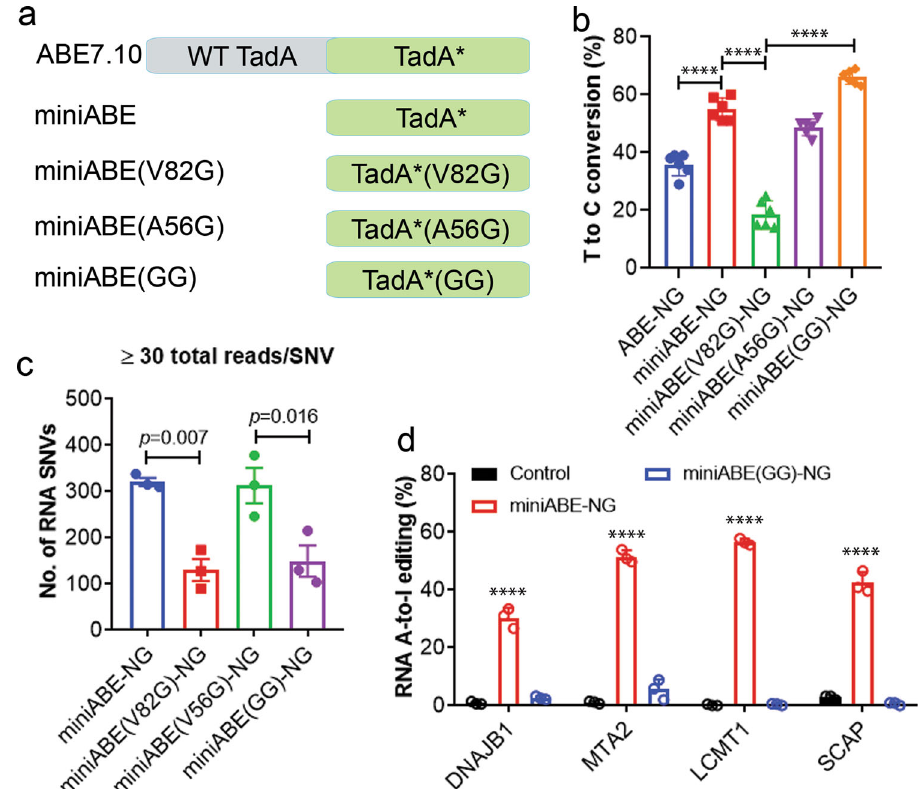
Fig. 3 Re-engineering the adenine deaminase domain to improve the ef fi ciency and speci fi city of ABE-NG. a Schematics of the adenine deaminase domain used in ABE-NG editors. b Quanti fi cation of the editing ef fi ciency of different ABE-NG variants with modi fi ed TadA* domain at the mdx 4cv target site. n = 6 wells/group; **** p < 0.0001; one-way ANOVA with Turkey ’ s multiple comparisons test. Data are mean ± SD. c The number of off-target RNA editing events in Neuro-2a cells transfected with different ABE-NG variants. n = 3 wells/group; one-way ANOVA with Turkey ’ s multiple comparisons test. Data are mean ± s.e.m. d Quanti fi cation of the off-target RNA editing (A-to-I) activities on four RNA adenines previously identi fi ed as being ef fi ciently modi fi ed by ABEmax in HEK293 cells. n = 3 wells/group; **** p < 0.0001; one-way ANOVA with Turkey ’ s multiple comparisons test. Data are mean ±